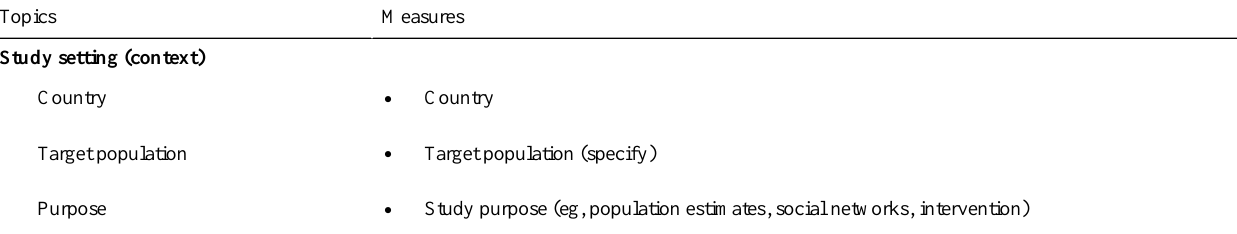
Table 2. Topics for data extraction and associated